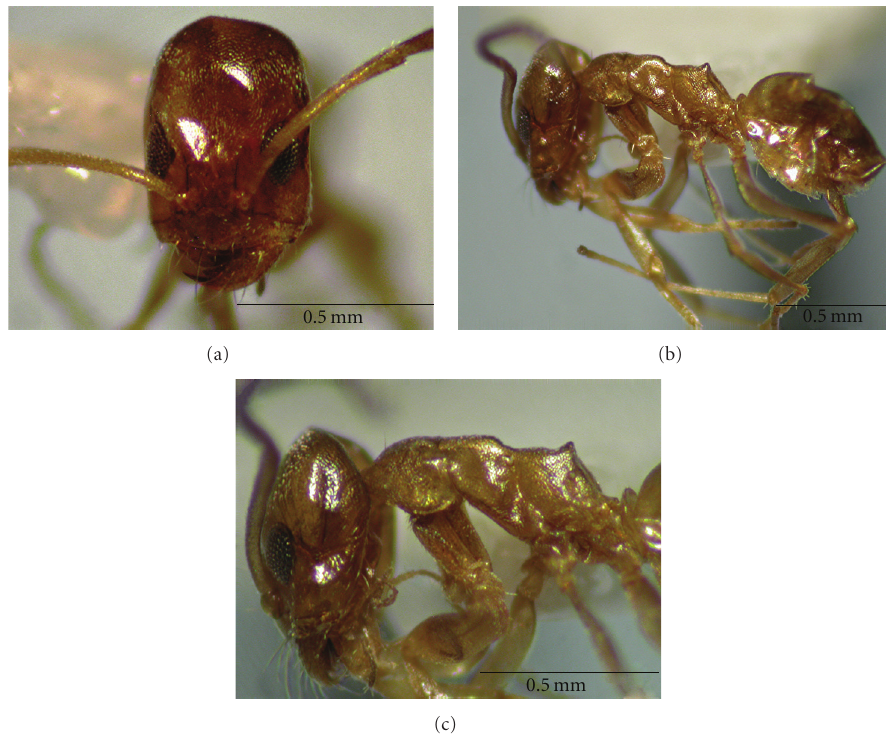
Figure 12: Dorymyrmex xerophylus n. sp. worker. (a) Head in full-face view; (b) and (c) body in lateral view; (c) body in dorsal view. These pictures were made by RJG using Nikon Coolpix digital camera and COMBINE Z5